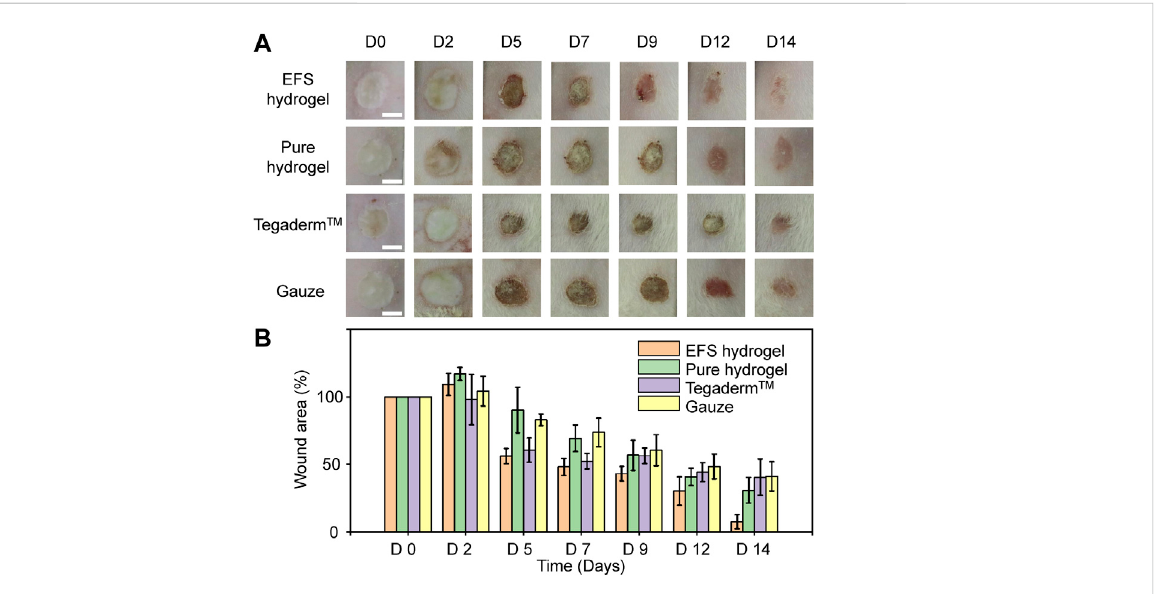
FIGURE 4 Burnhealingperformancetreatedbyvarious dressings. (A) Digitalphotosofburnwoundafter0,2,5,7,9,12and14 daystreatment byEFShydrogel, pure hydrogel, commercial Tegaderm ™ dressing, and gauze, respectively. (B) Statistical wound areas of the corresponding treatment during 14